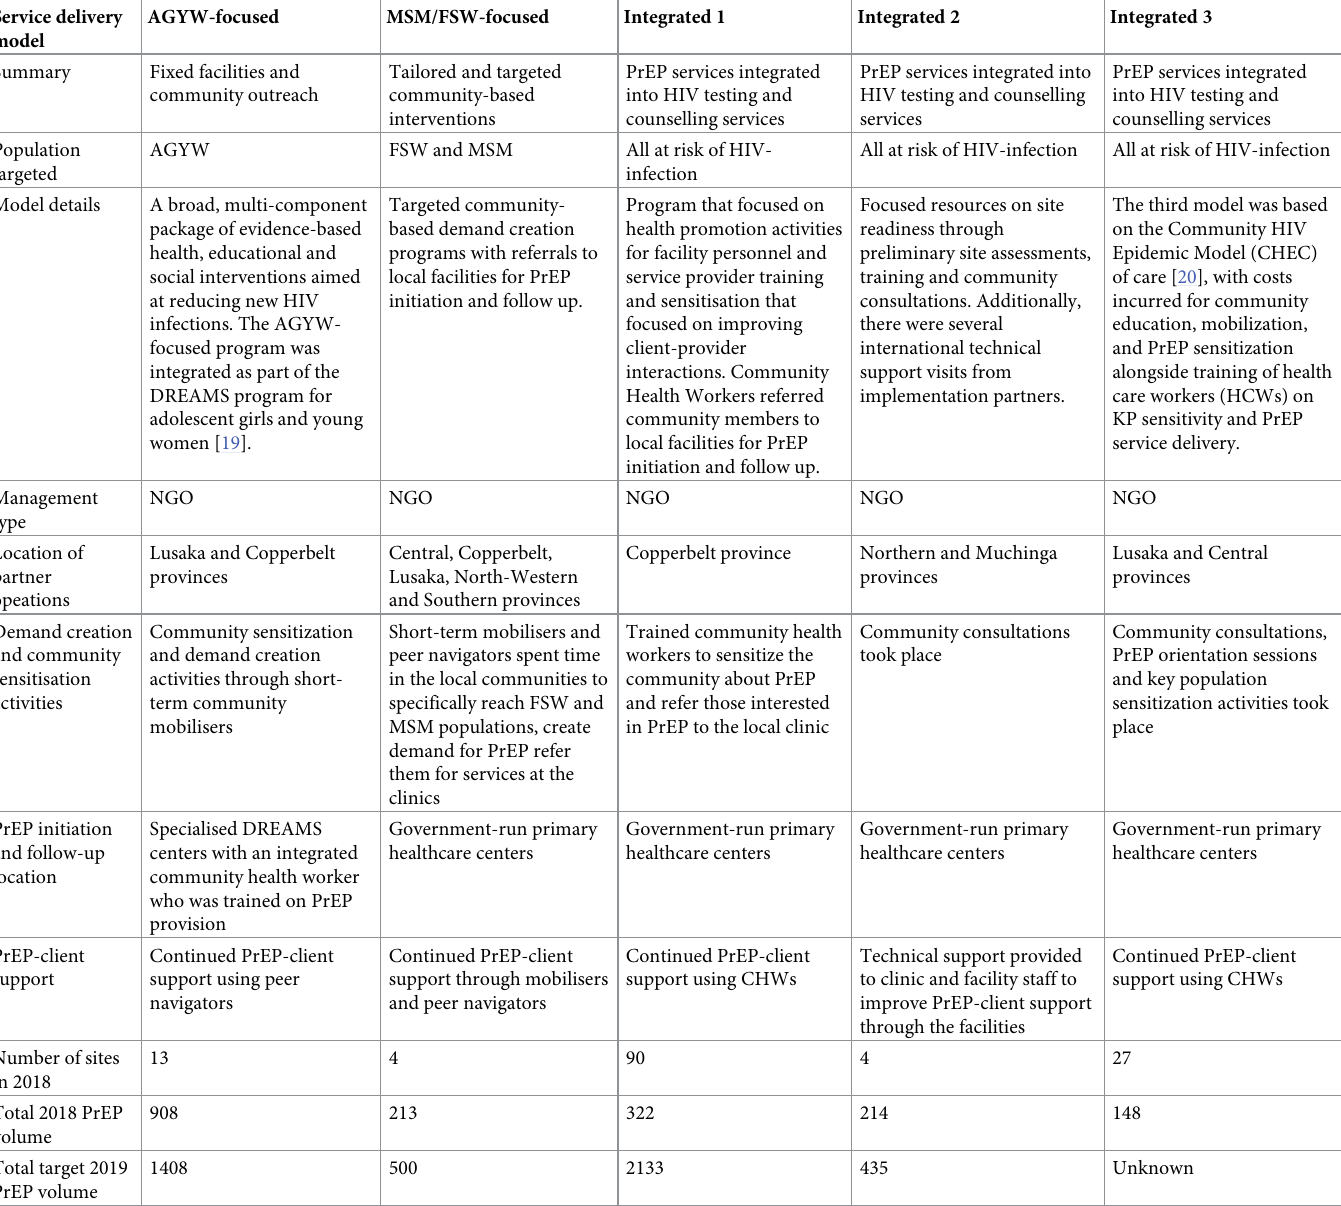
Table 2. Description of the service delivery models